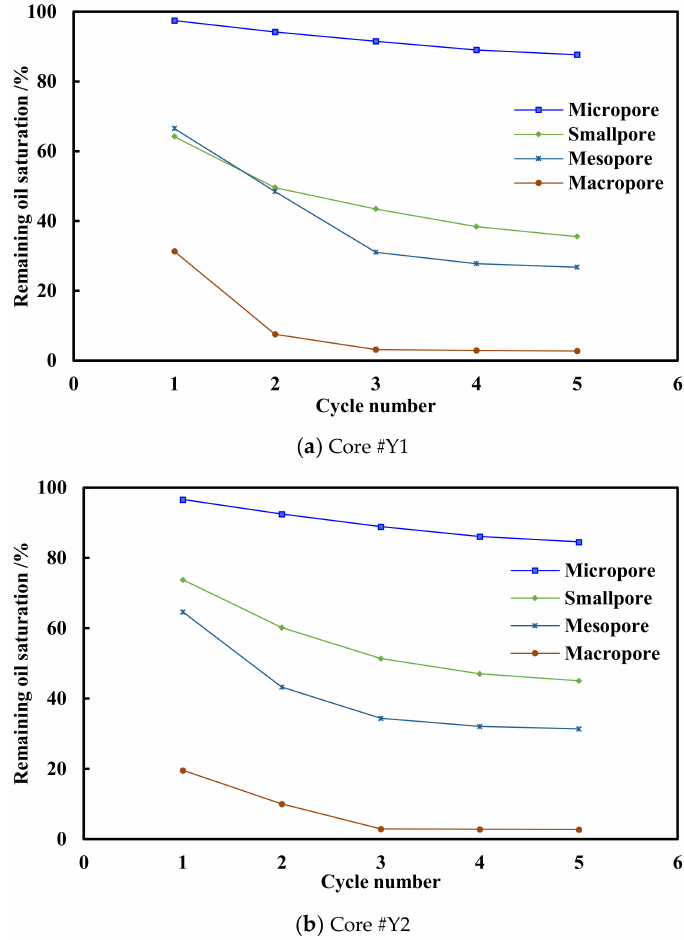
Figure 12. Remaining oil saturation in different pore scales.